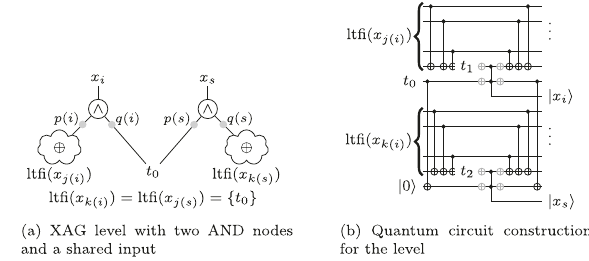
Fig. 6 Compilation of an XAG level with two AND nodes using algorithm 2. a XAG level with AND nodes x i and x s ; b compiled quantum circuit with a single T Algorithm 2: minimizing the T-depth